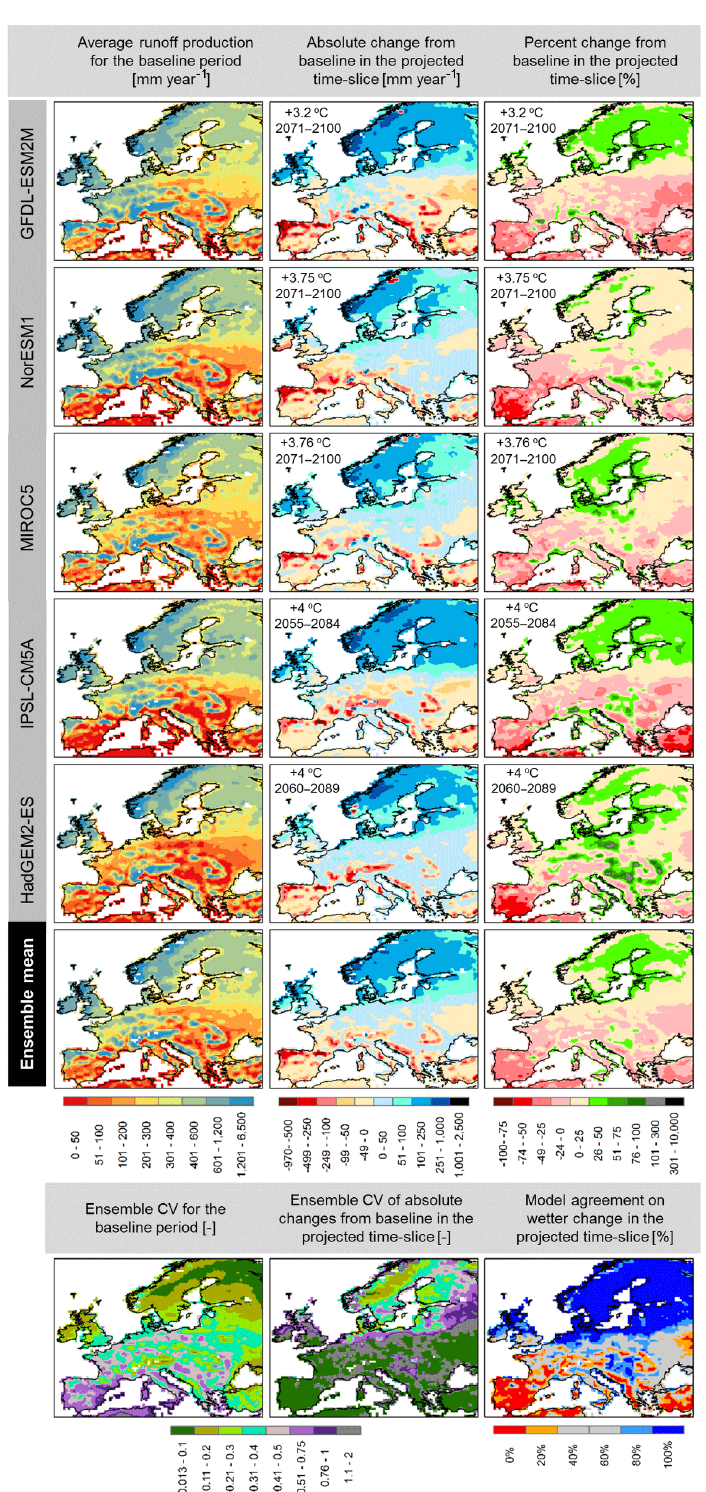
Figure 2. Average runoff production from raw Euro-CORDEX data for all dynamical downscaled GCMs and their ensemble mean. Runoff production averaged over the baseline period (1976–2005) (left column panels), absolute change in runoff in the + 4 SWL projected time slice (middle column panels) and percent change in the + 4 SWL projected time slice (right column panels). Bottom row panels: coefficient of variation of the ensemble members for the baseline period (left column panels), coefficient of variation of the projected absolute changes in the + 4 SWL projected time slice (middle column panels) and model agreement towards a wetter change in the + 4 SWL projected time